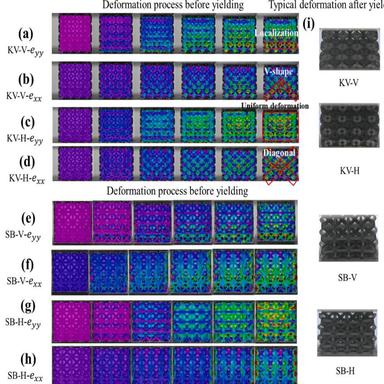
Deformation modes.